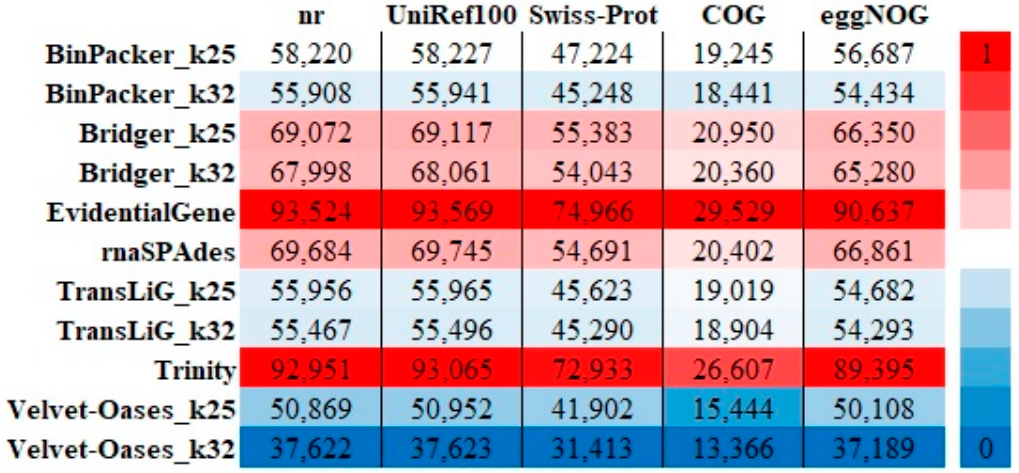
Figure 5. Comparison of assemblies in terms of transcripts that potentially encode for a protein.